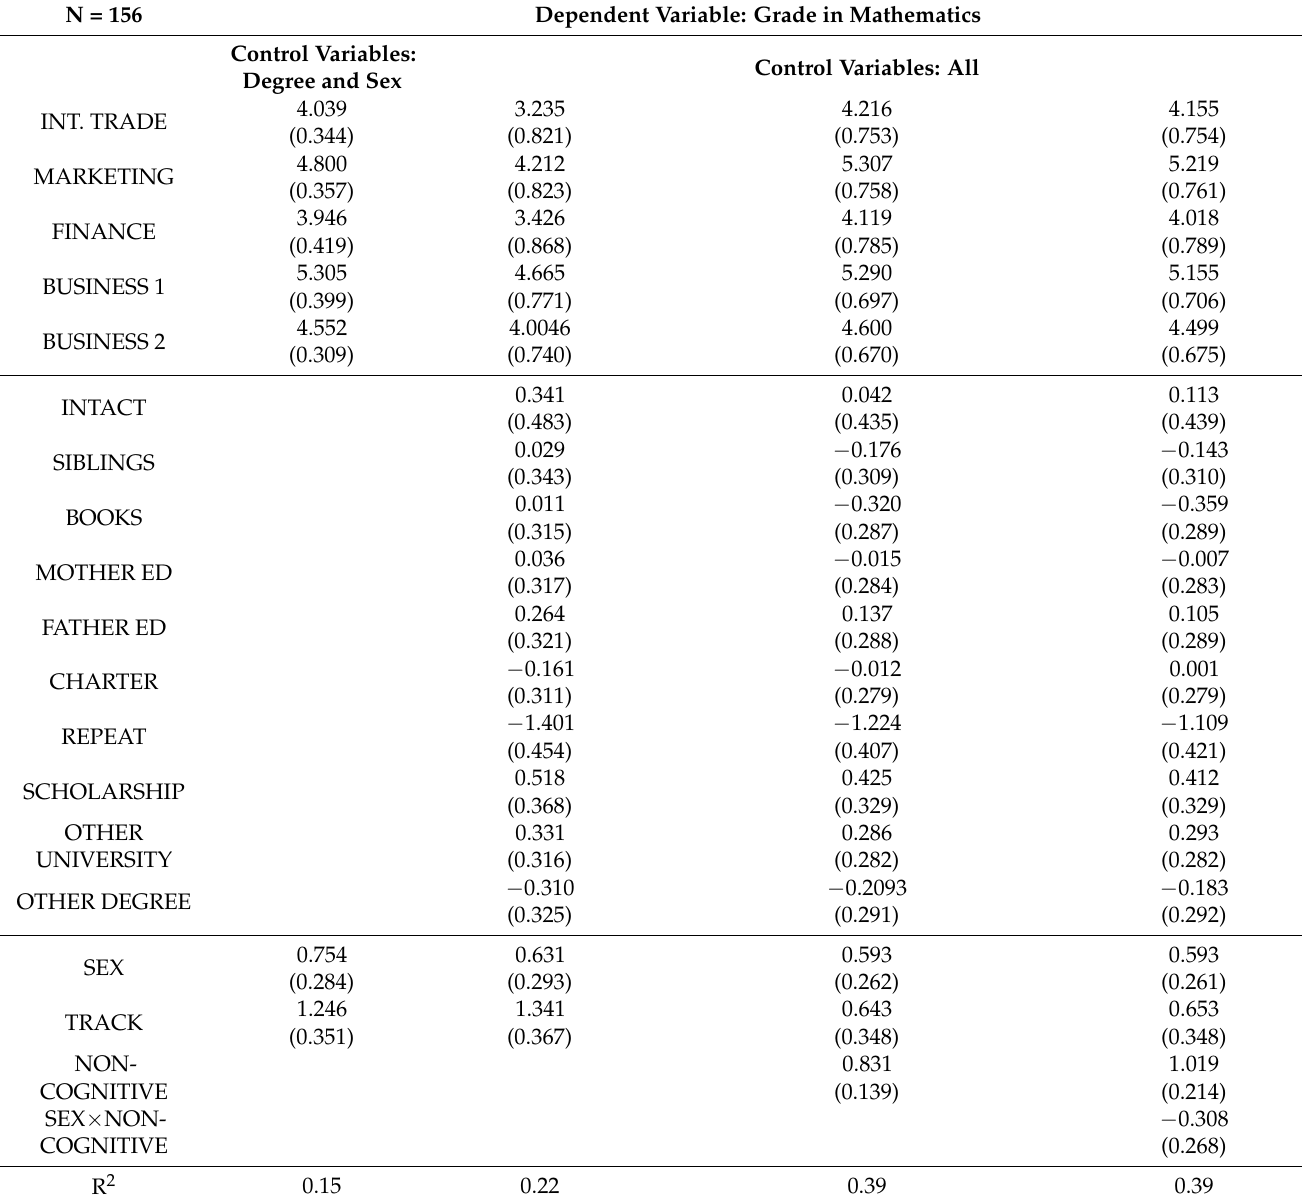
Table A1. Coefficients of linear models explaining grades (full sample).